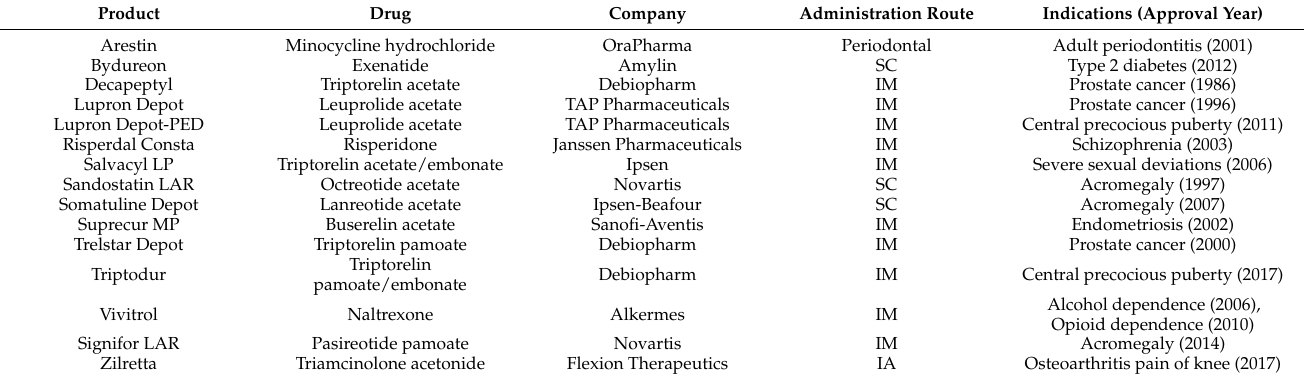
Table 1. PLA/PLGA-based microparticle formulation products approved by EMA and